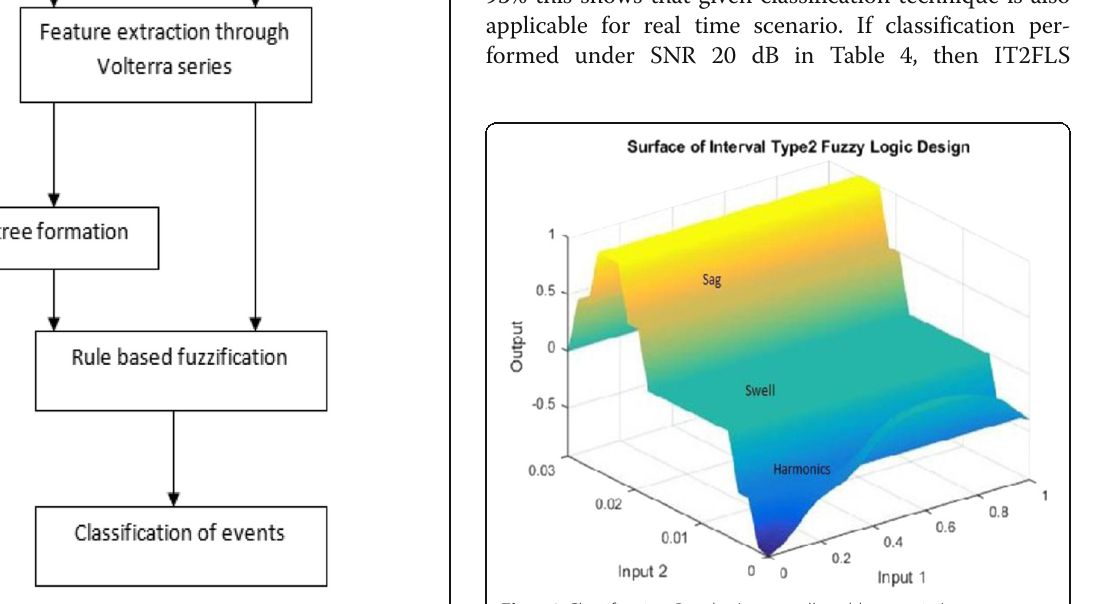
Fig. 10 Classification Results (sag, swell and